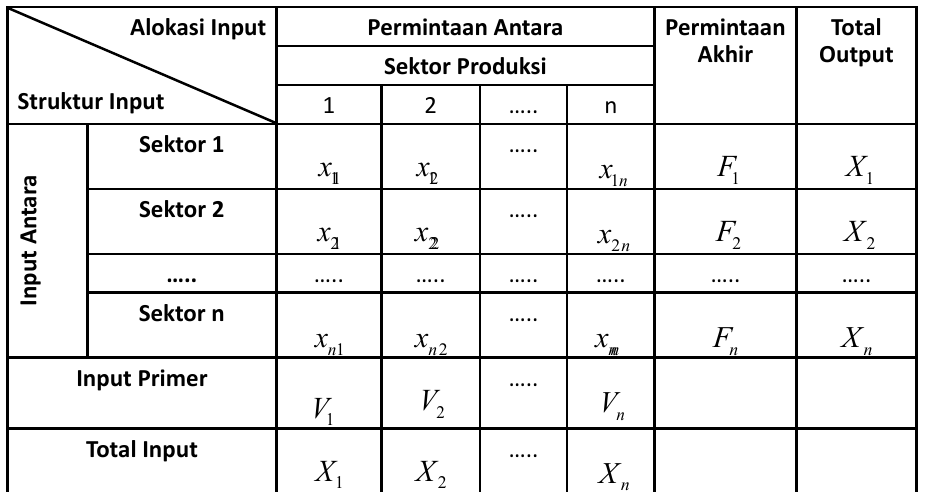
Table 4: Illustration of Input-Output Table Alokasi